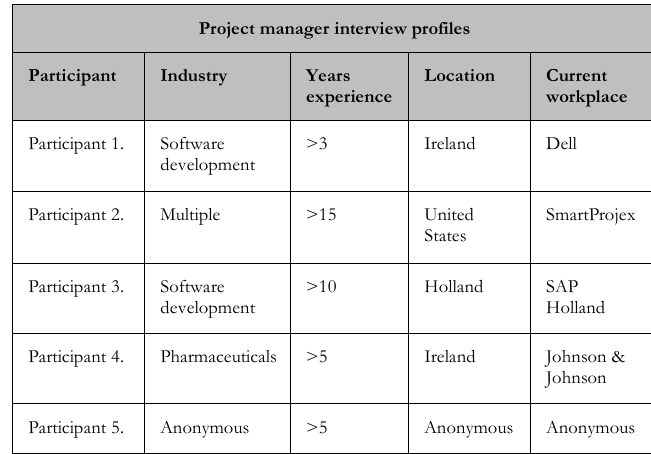
Table 1. Project manager profiles